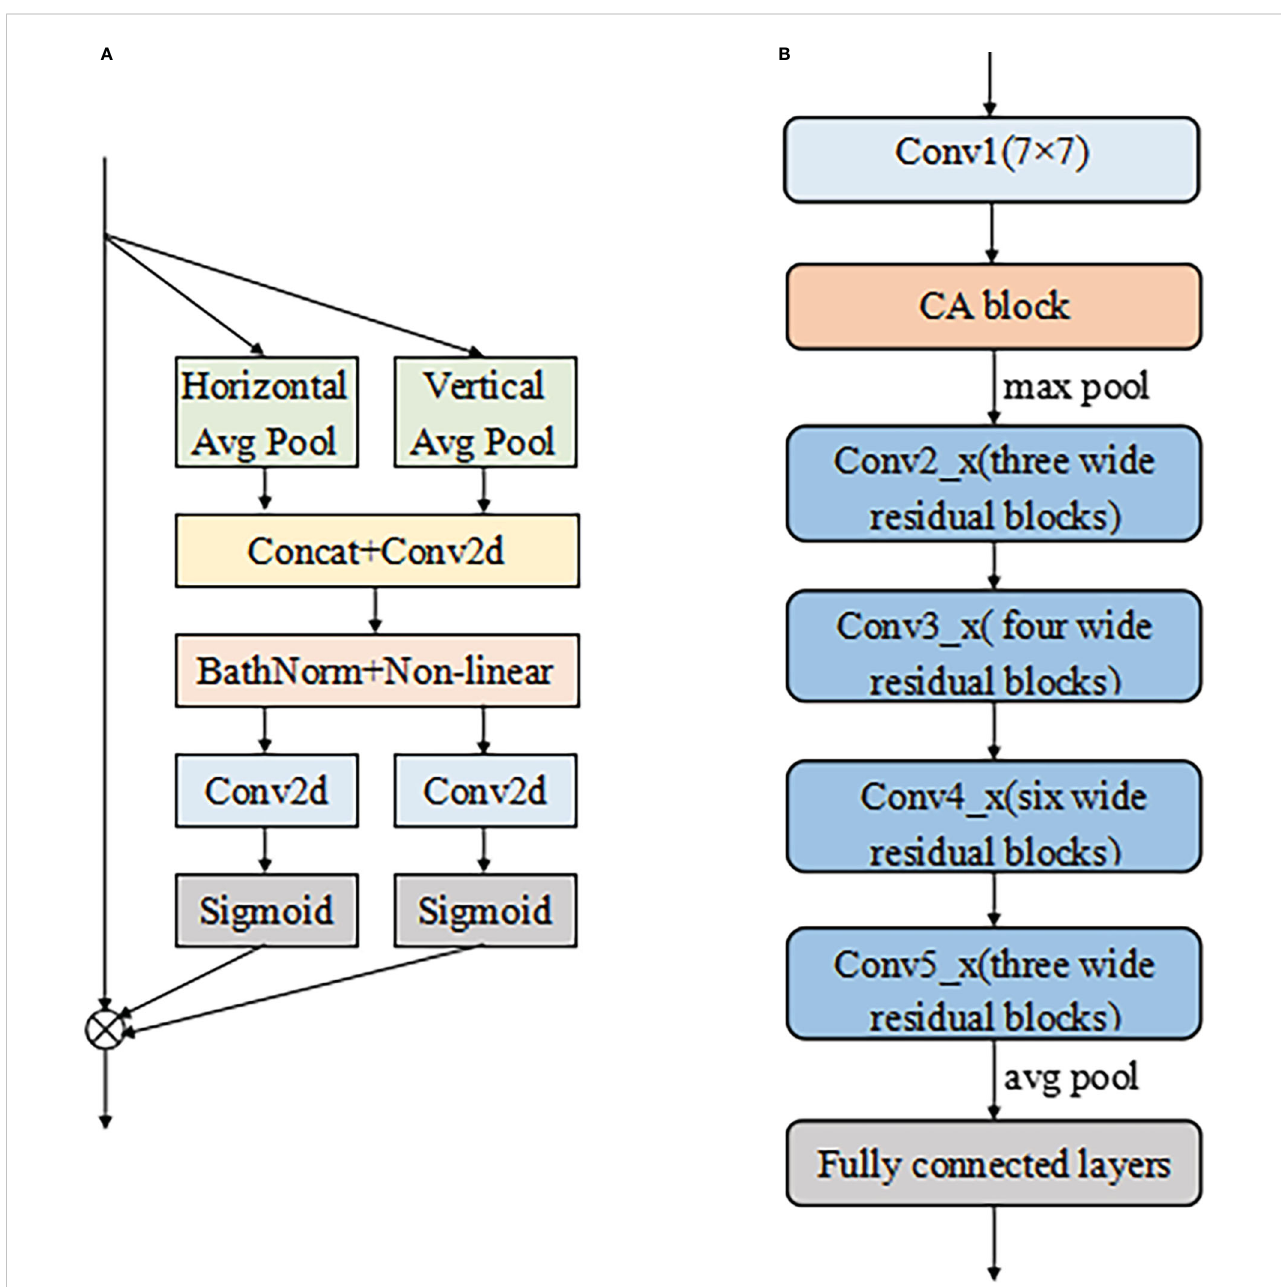
FIGURE 6 The structure of CA module (A) and the proposed A-ResNet50-W model (B) . Here the symbol ⊗ represents